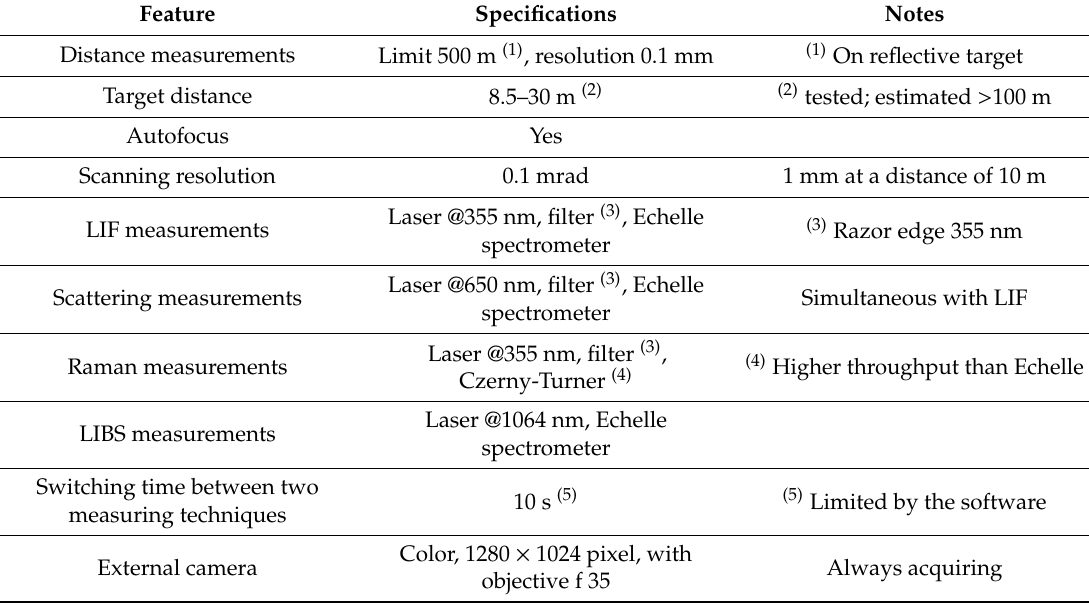
Table 1. Specification of the ILS system.